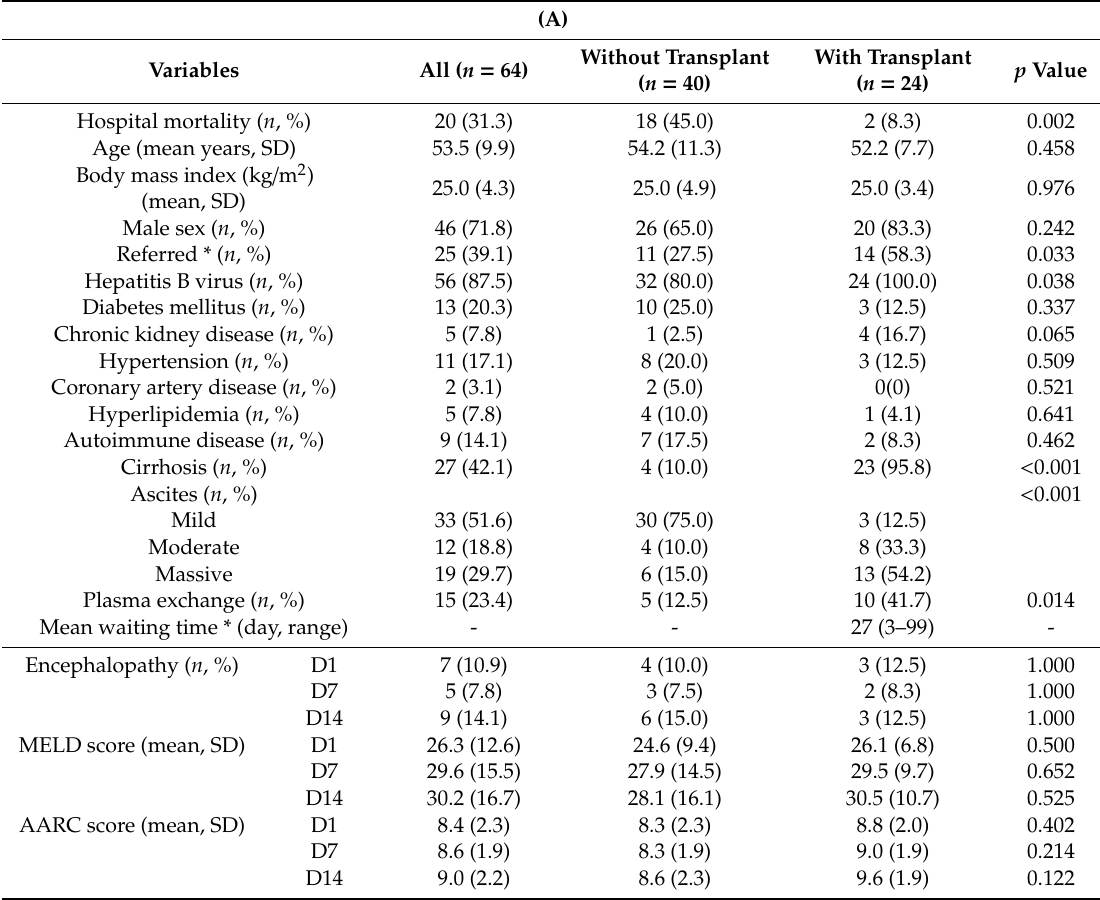
Table 1. Characteristics of patients with acute-on-chronic liver failure (ACLF) (clinical (A) and laboratory (B)